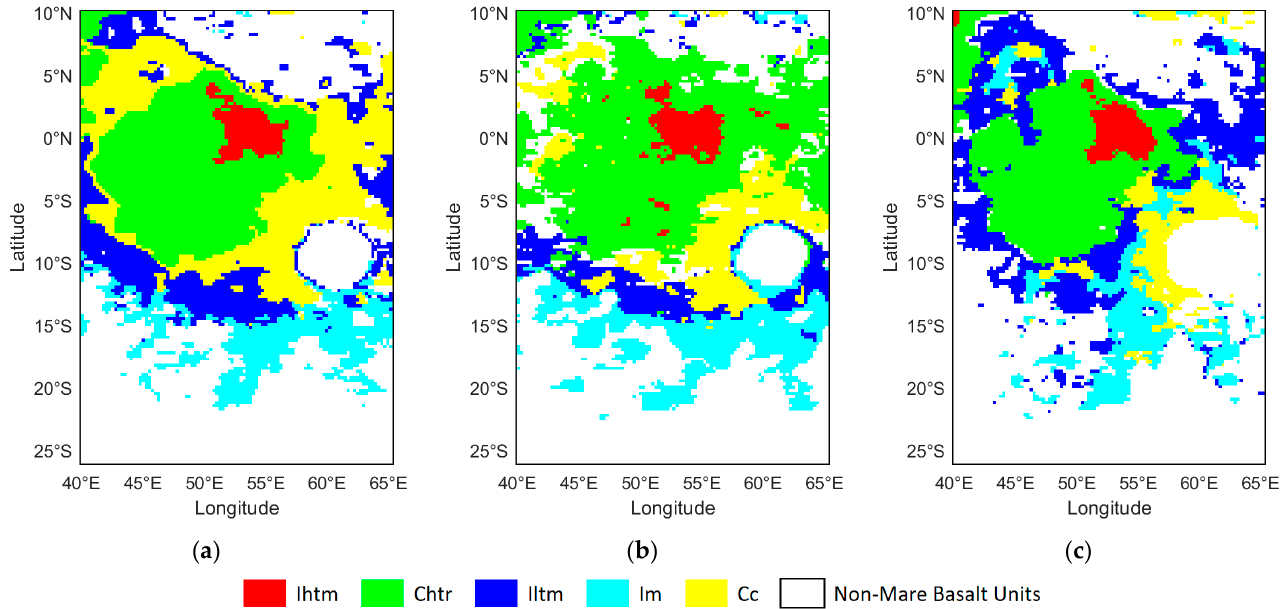
Figure 18. Classi fi cation with di ff erent acquisition time and dT B features. ( a ) T B noon features; ( b ) T B mid- Figure 18. Classification with different acquisition time and dT B features. ( a ) T B noon features; night features; ( c ) dT B features. ( b ) T B midnight features; ( c ) dT B